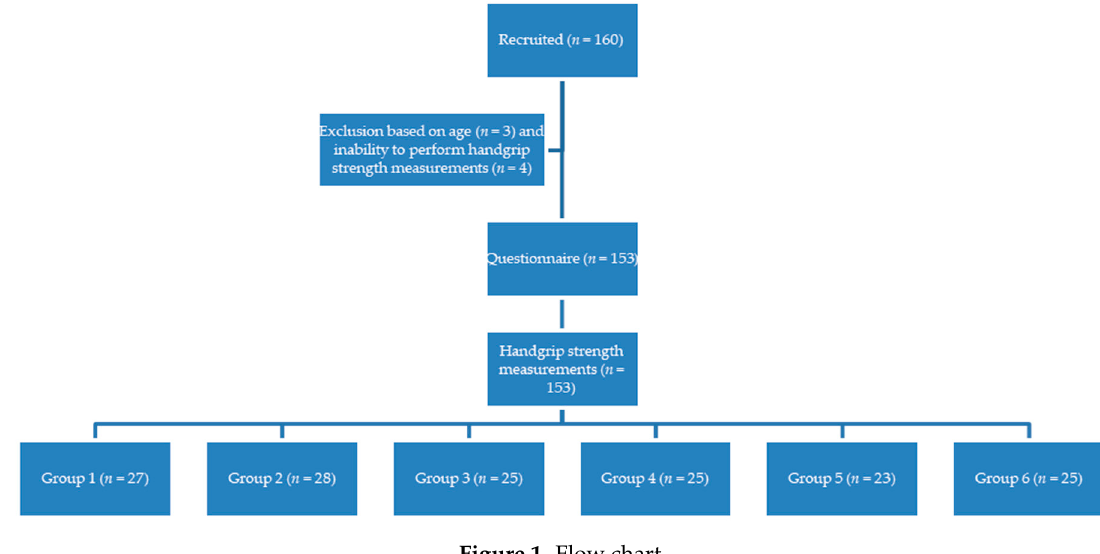
Figure 1. Flow chart. Table 2. Patient Characteristics.